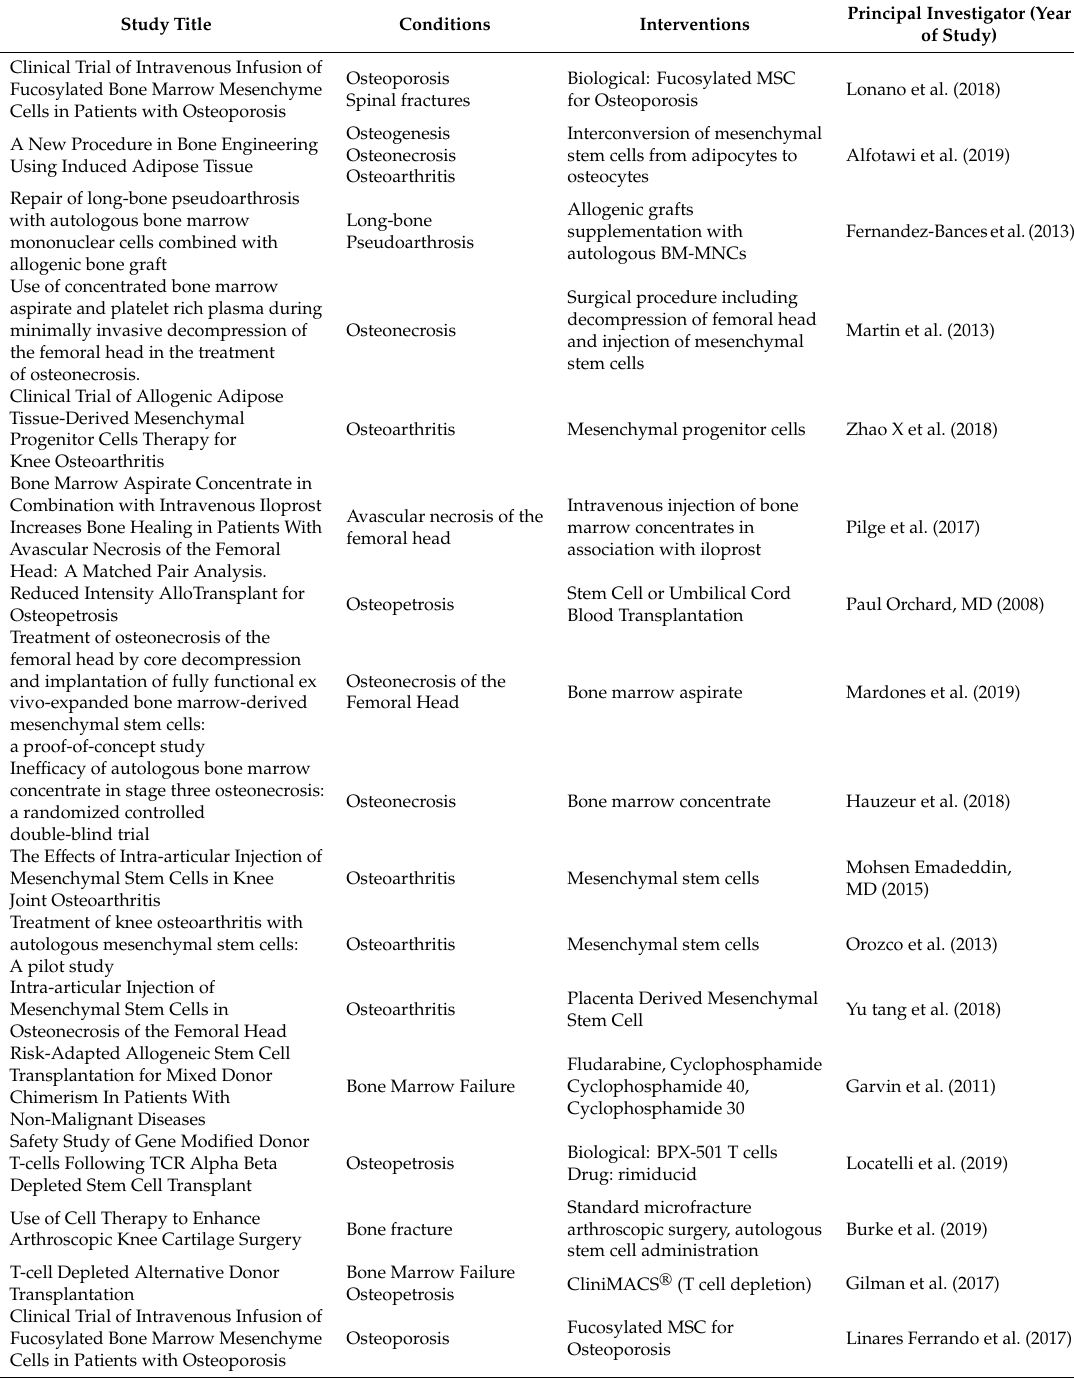
Table1. AnoverviewoftherecentlycompletedclinicaltrialsthatemployedASCsandMSCsintreatment ofbone relateddiseases. Allstudies canbe foundin theClinicalTrialsdatabase (https: // clinicaltrials.gov / ) using references